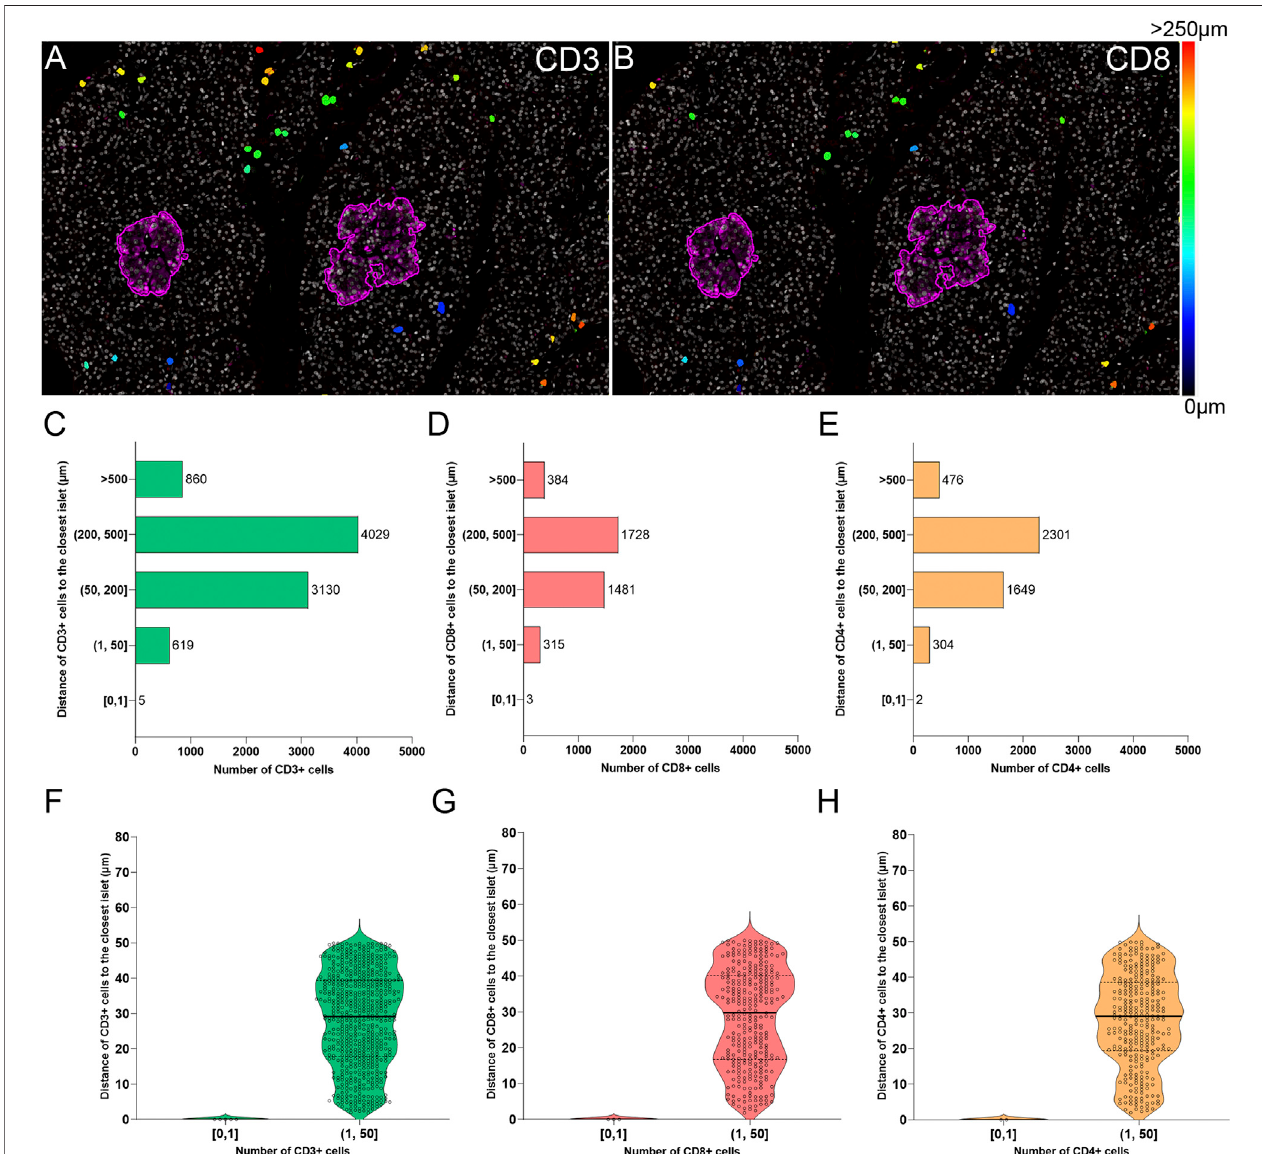
FIGURE 7 | Two-dimensional spatial analysis of the localization and distance of immune cells to the islets. Heatmaps showing the distance of (A) CD3+ and (B) CD8+ cells to the closest islet. Scale: 0 (black-blue) — > 250 (red) μ m. (C) Bar graph showing the distribution of CD3+, (D) CD8+, and (E) CD4+ cells in fi ve different distance categories to the closest islet: [0, 1), (1, 50], (50, 200], (200, 500], and > 500 μ m. (F) Violin plots showing the number of CD3+, (G) CD8+, and (H) CD4+ cells in the intra-islet [0, 1) and peri-islet (1, 50 μ m]. Each dot represents a cell.